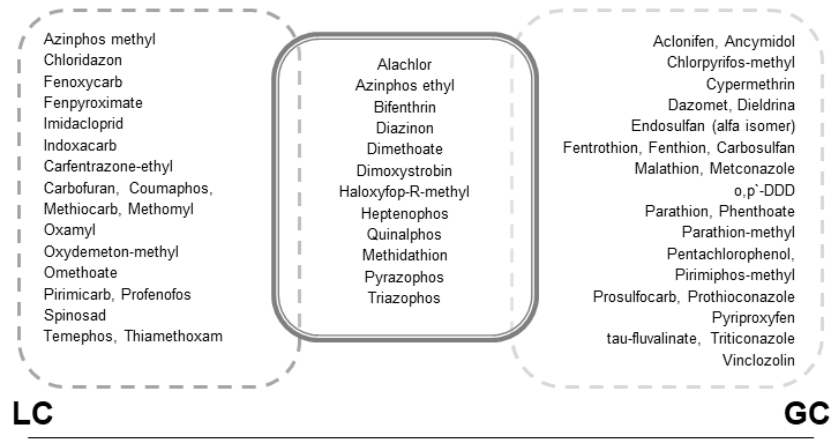
Figure 3. Information on the identification and detection of the selected analytes using the developed analytical methods (LC and GC).